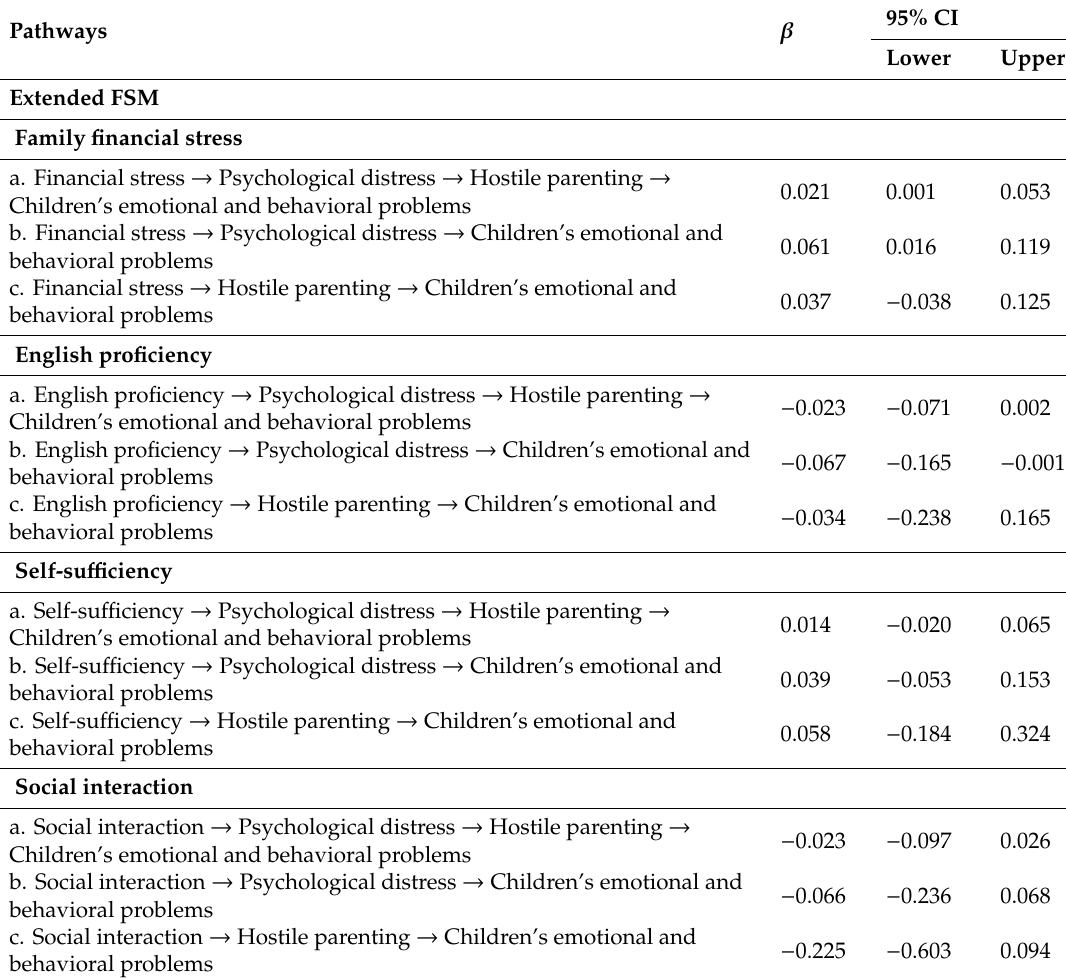
Table 4. The indirect e ff ects of financial stress, English proficiency, self-su ffi ciency, social interaction, and self-identity on children’s emotional and behavioral problems in the Multilevel Structural Equations Model